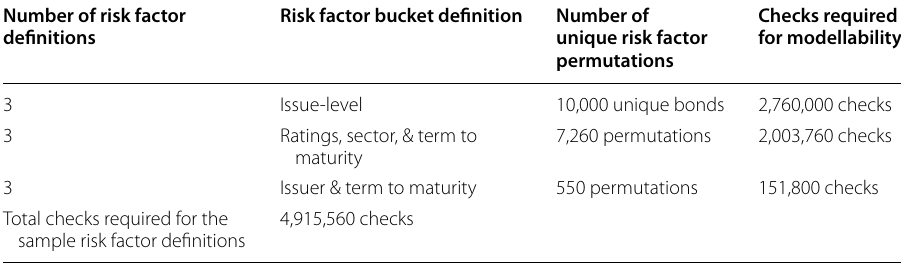
Table 1 Number of computational checks needed given the sample set of data Number of risk factor